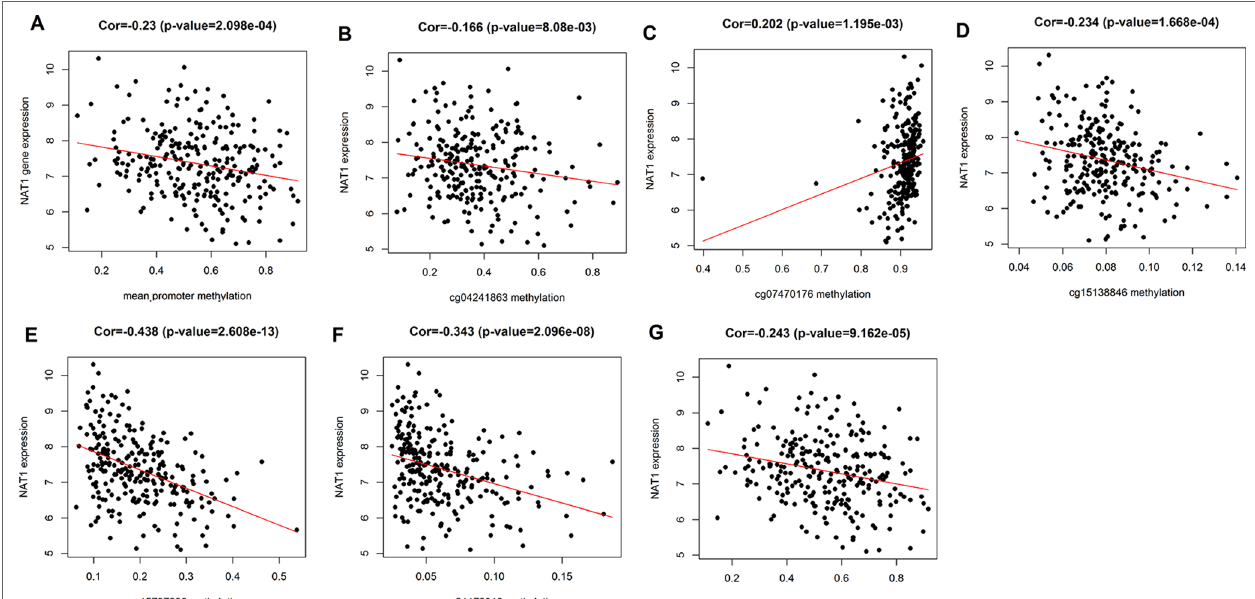
FIGURe 2 | (A) Correlation analysis of N - acetyltransferase 1 ( NAT1 ) mRNA with the mean methylation of promoter region; (B – G) Correlation analysis of NAT1 mRNA with cg04241863, cg07470176, cg15138846, cg15797286, cg21172319, cg21298408.